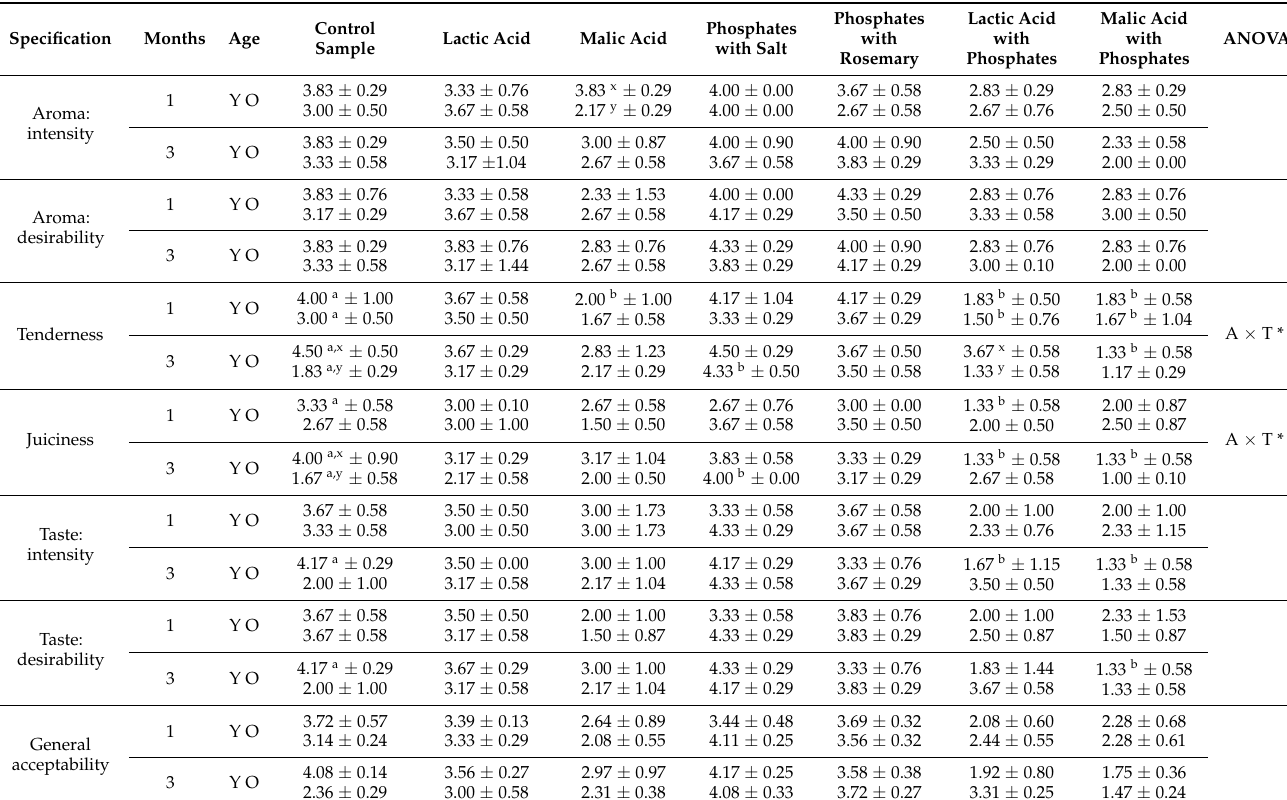
Table 4. Sensory properties of the tested horse meat samples (from each age group: 12 carcasses × 2 parts of muscle samples × 7 steaks = 168 samples of steaks) (%, x ±